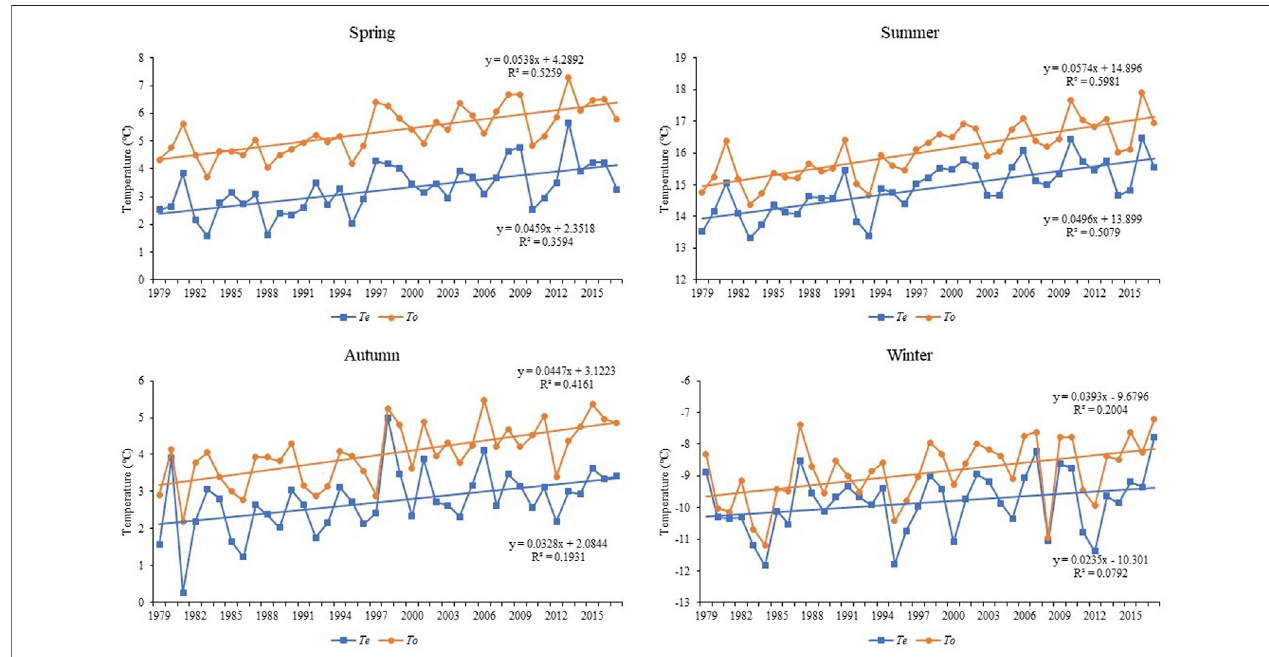
FIGURE 6 | Average seasonal mean temperature from station time series and ERA5-Land in the 1979 – 2017 period for QLM.